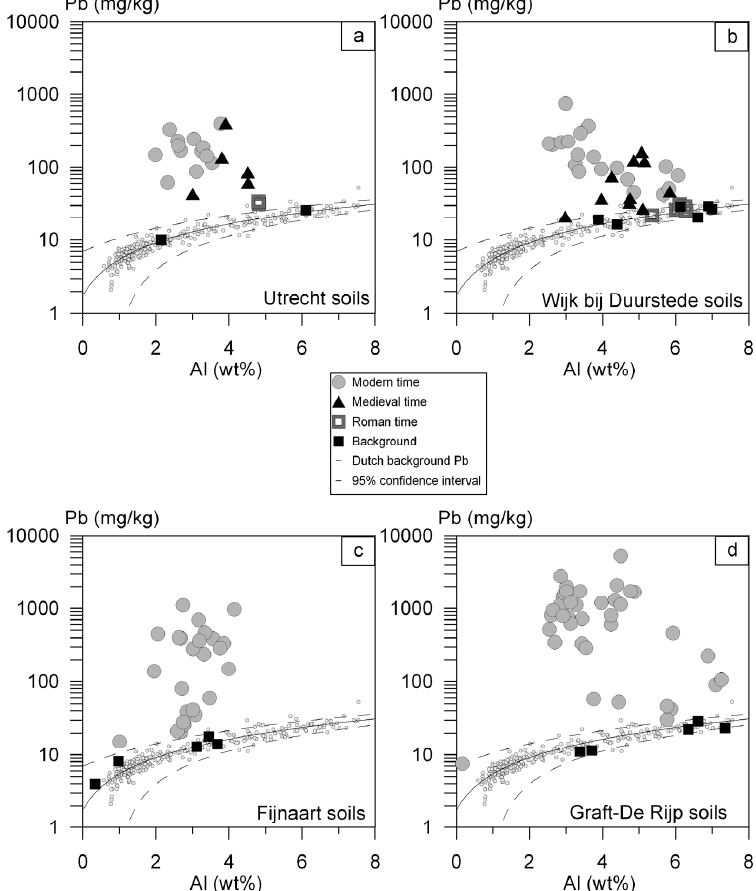
Figure 2. Pb content (mg/kg) of the soil samples—background or influenced in the Roman, Medieval or Modern time— versus Al content (wt.%) per city/village. The line indicates the average relationship between the Al and Pb content of unpolluted Dutch sedimentary soils, based on 303 samples ( ● ) [47]. The dashed lines are the 95% confidence intervals of the relationship between Al and Pb. a = Utrecht; b = Wijk bij Duurstede; c = Fijnaart; d = Graft-De Rijp.